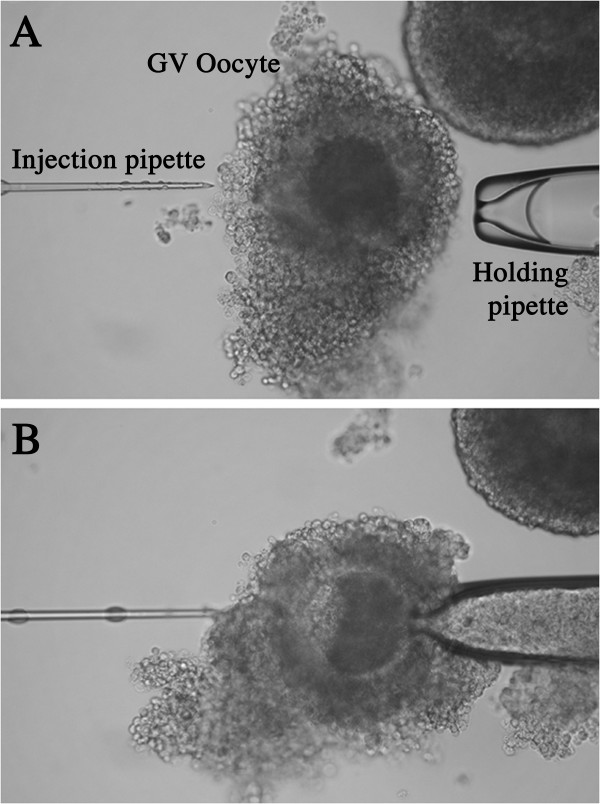
Oocyte microinjection. The short hairpin (sh)RNAi microinjection of a the germinal vesicle (GV) stage bovine oocyte. (A) The oocyte has been localized and is subsequently microinjected with shRNAi molecules (B). The oocyte is being held by the holding pipette and microinjected by a pipette of 4 μm in diameter and beveled at 35°. Care was taken not to strip off the cumulus cells surrounding the GV oocytes and to avoid perforating the germinal vesicle during microinjection.